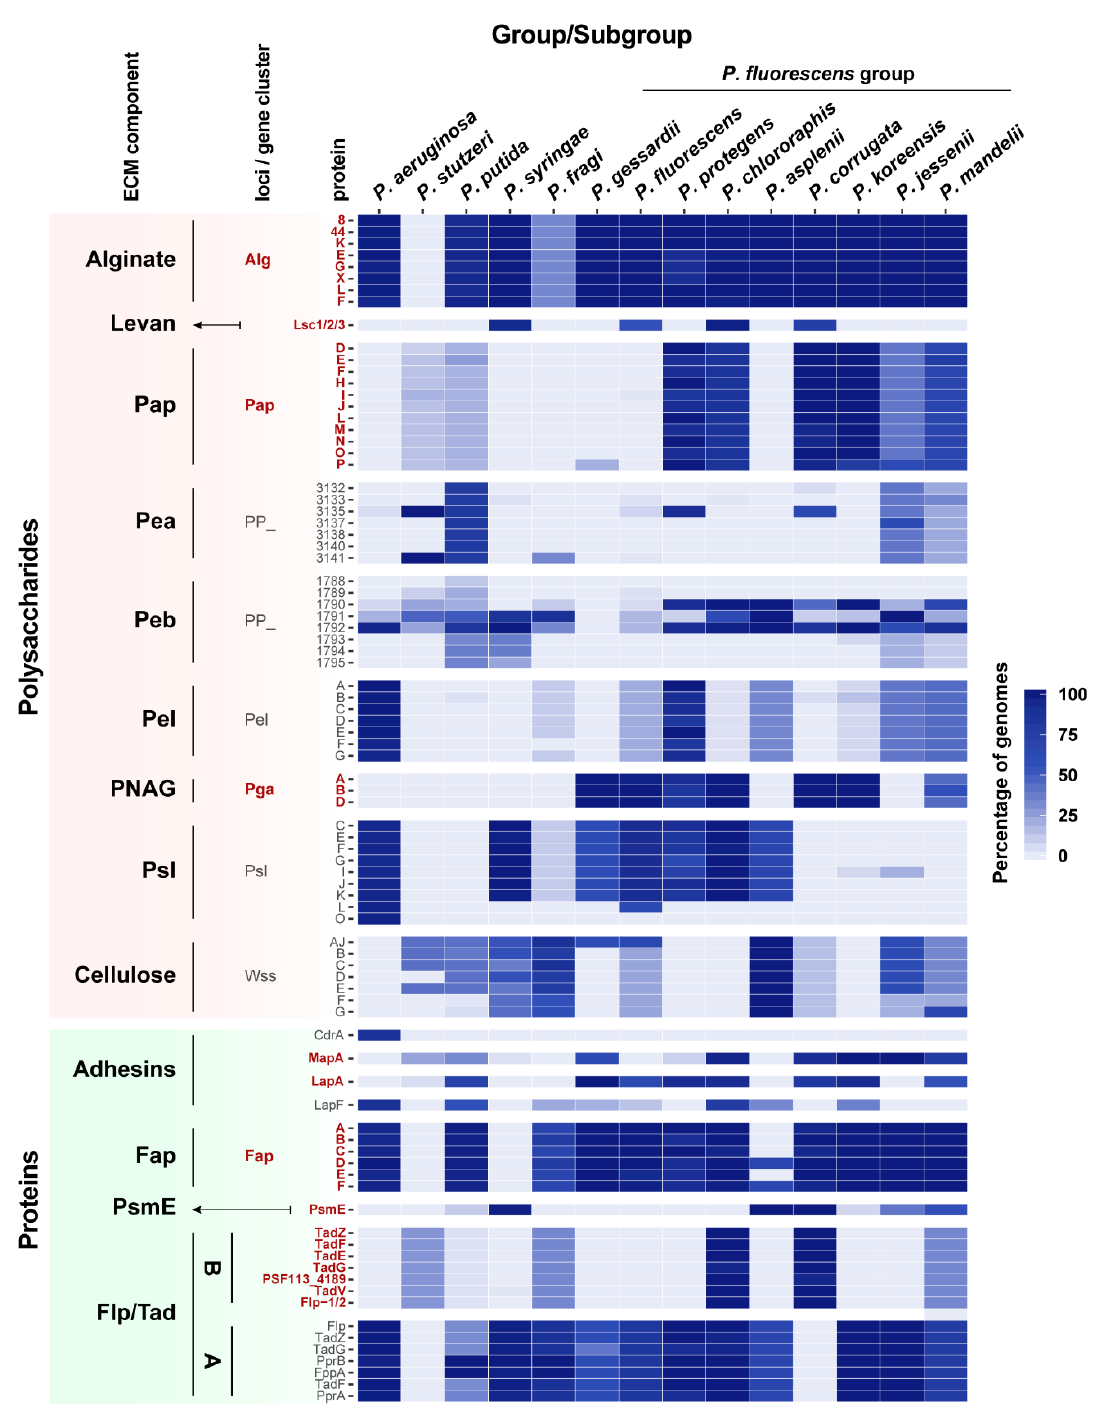
Figure 4. Occurrence of ECM components in Pseudomonas strains. Heatmap showing the phylogenetic distribution of ECM components within the Pseudomonas genus. Distribution based on the reconstructed phylogenetic tree (Supplementary Figure S2, including the 571 genomes classified in larger groups) and reordered according to Garrido-Sanz et al., 2016 [3] and Garrido-Sanz et al., 2017 [39]. Selected ECM components include alginate, levan, Pap, Pea, Peb, Pel, PNAG, Psl, cellulose, CdrA, MapA, LapA, and LapF, Fap, PsmE, and Flp / Tad pilus type A and B. For the polysaccharides components (except for levan) and the Flp / Tad system, only a subset of proteins is shown because they contain proteins that are part of larger orthologous groups not specific to these clusters. Color scale represents the percentage of genomes containing an ortholog in each group or subgroup. Gene names in bold indicate whether they are present in the F113